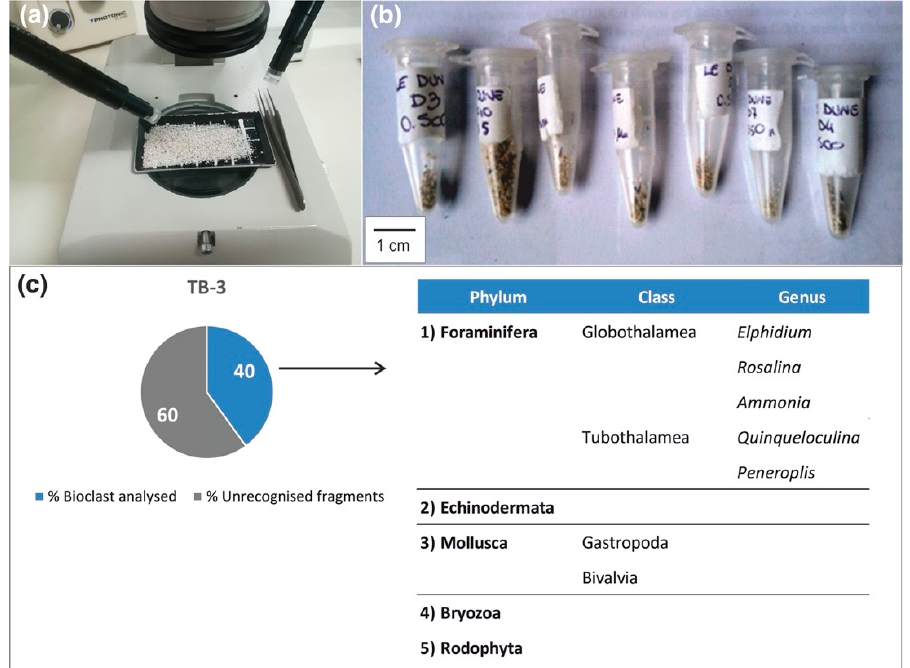
Figure 6. Example of bioclast evaluation procedure; ( a ) sample bioclast separation with a set of tweezers; ( b ) isolated bioclasts in test tubes; ( c ) bioclast classification.